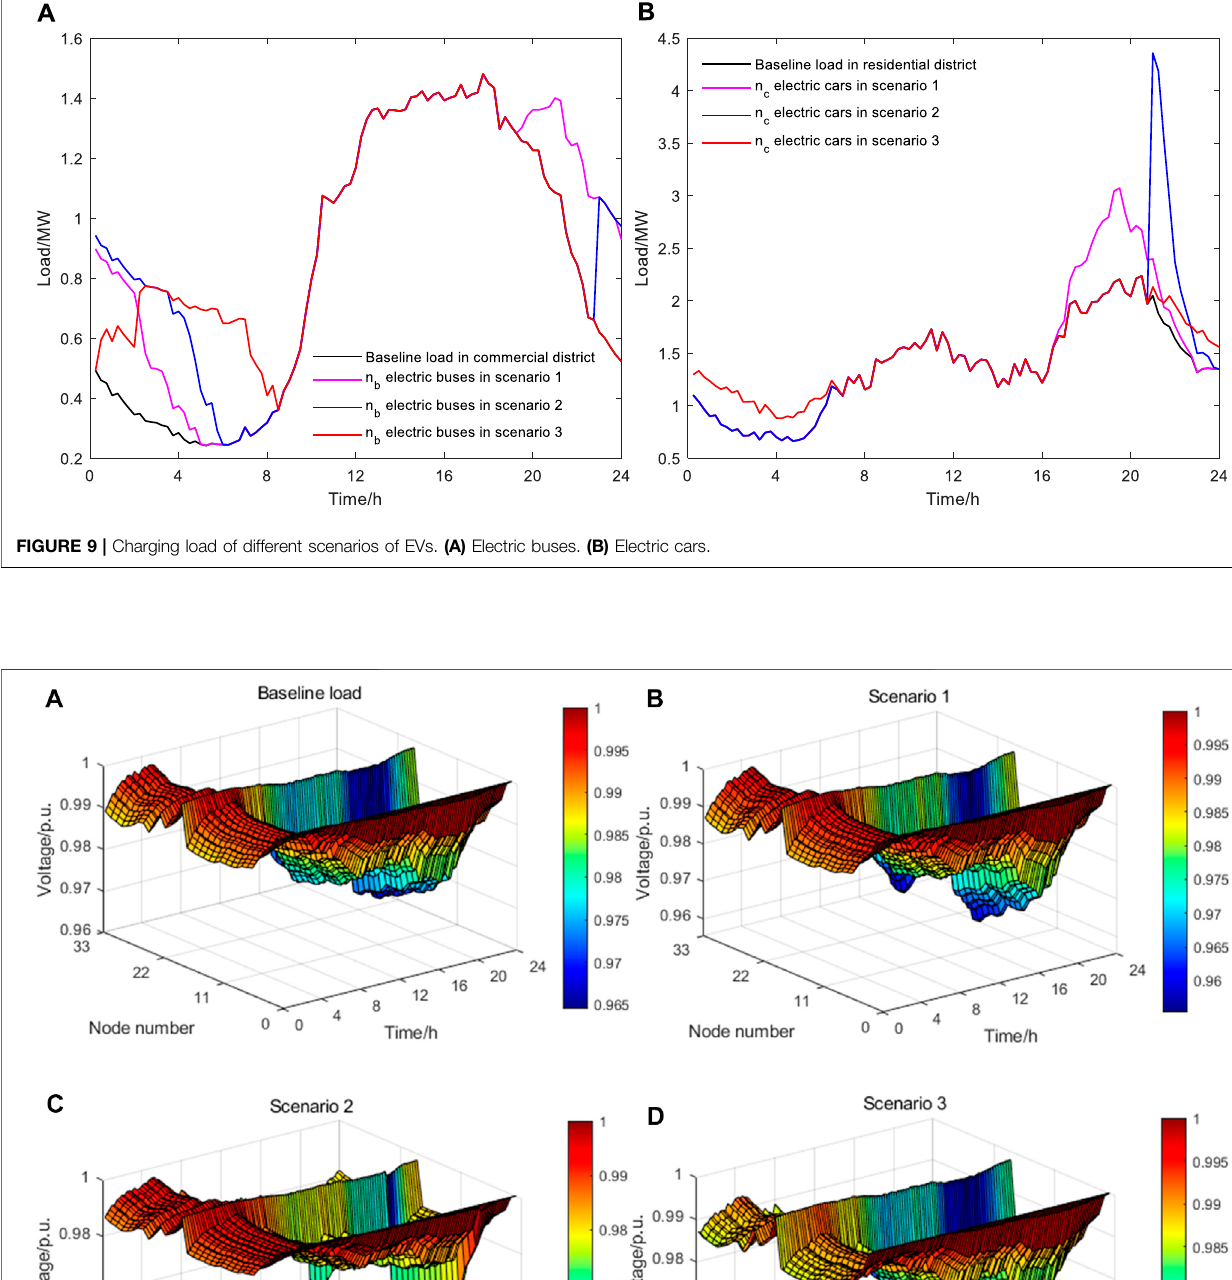
Frontiers in Energy Research |